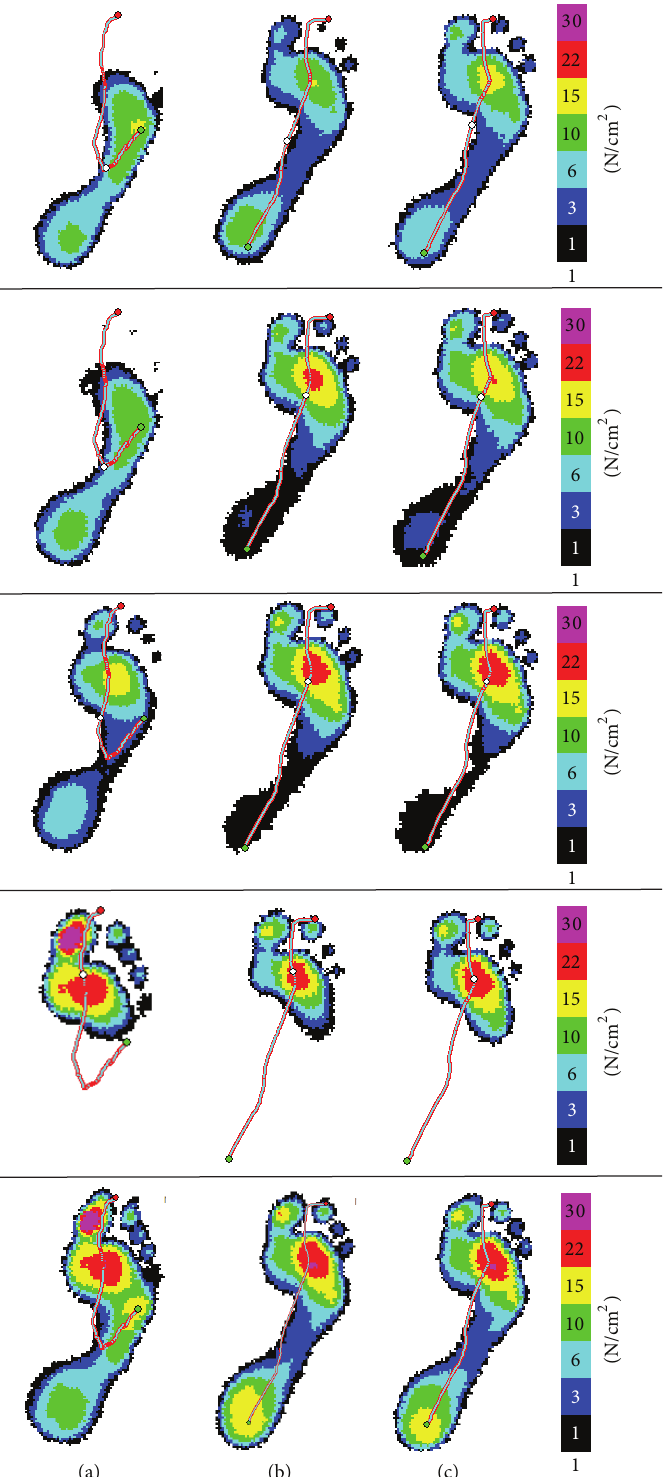
Figure 2: Averaged maximum pressure: (a) before treatment, (b) after 8 weeks of treatment, and (c) one month after treatment. In this figure (a) the patient started placing the foot on the floor by the lateral border of the foot as shown by the pathway of the center of pressure (rollover). In (b) and (c), the center of pressure starts at the heel and passes in the middle of the foot indicating balanced forefoot placement and appropriate timing. The last row shows the averaged maximum pressure of all